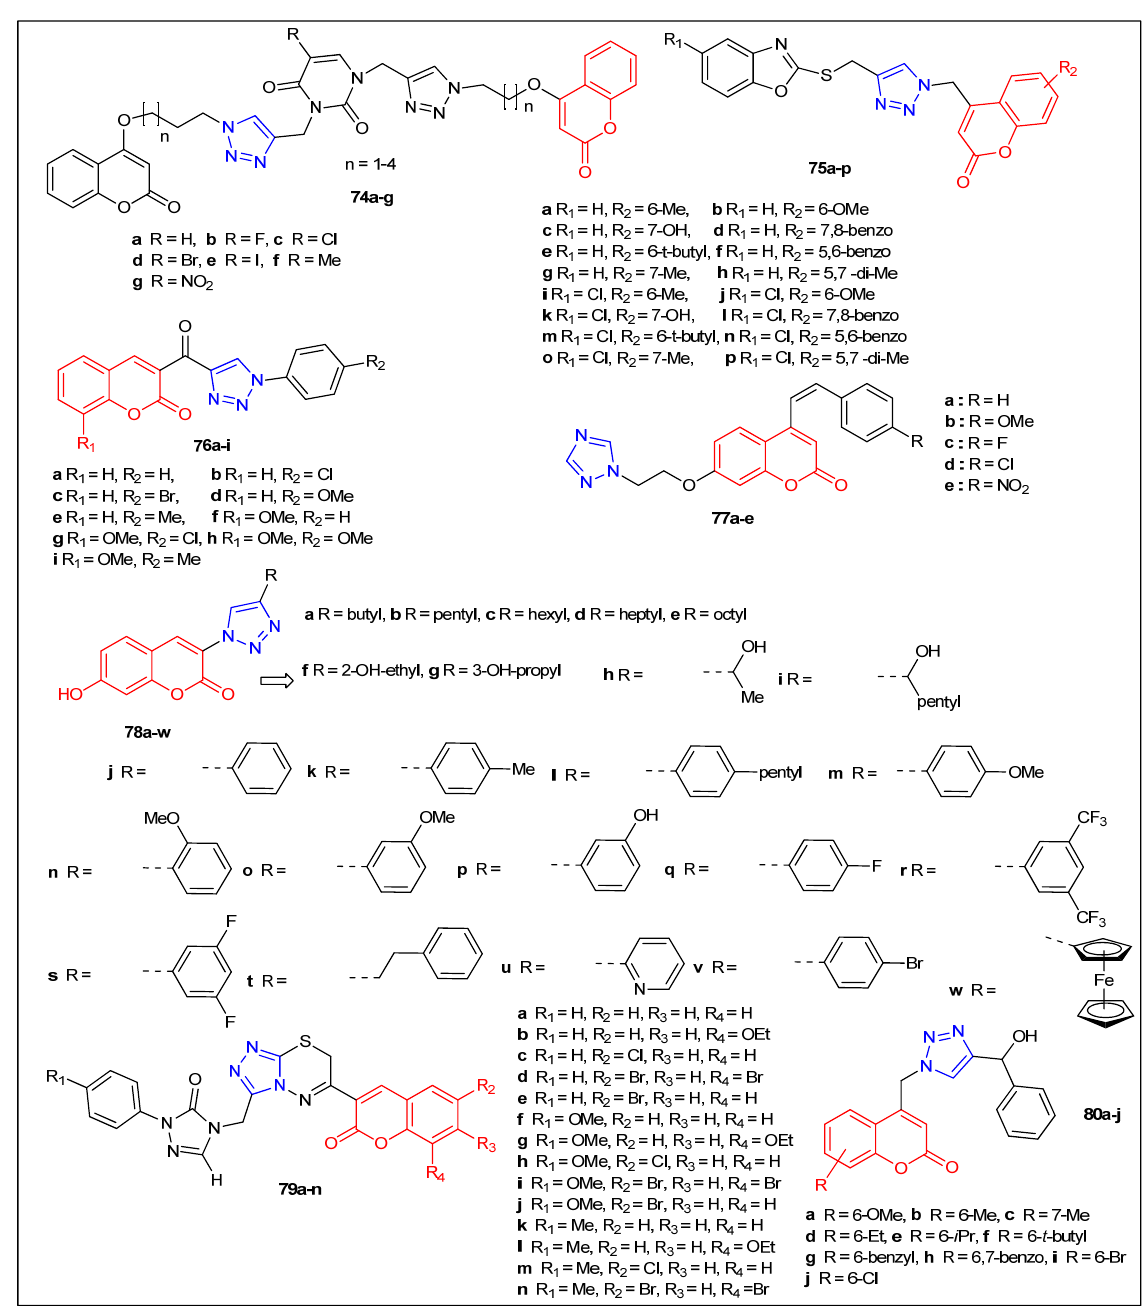
Figure 9. Structures of the reported coumarin triazole derivatives from 2021 – 2022 . Synthesis of new hybrids of 3-(1,2,3)-trazolyl-coumarin derivatives [ 78a – w ] (Figure 9) was reported by Kraljevic et al. [64]. All hybrids of 3-(1,2,3)-trazolyl-coumarin derivatives [ 78a – w ] were tested toward Gram-positive S. aureus , S. aureus MRSA, E. faecali , E. faecium VRE, and Gram-negative E. coli , K. pneumoniae , K. pneumoniae ESBL, P. and A. baumannii